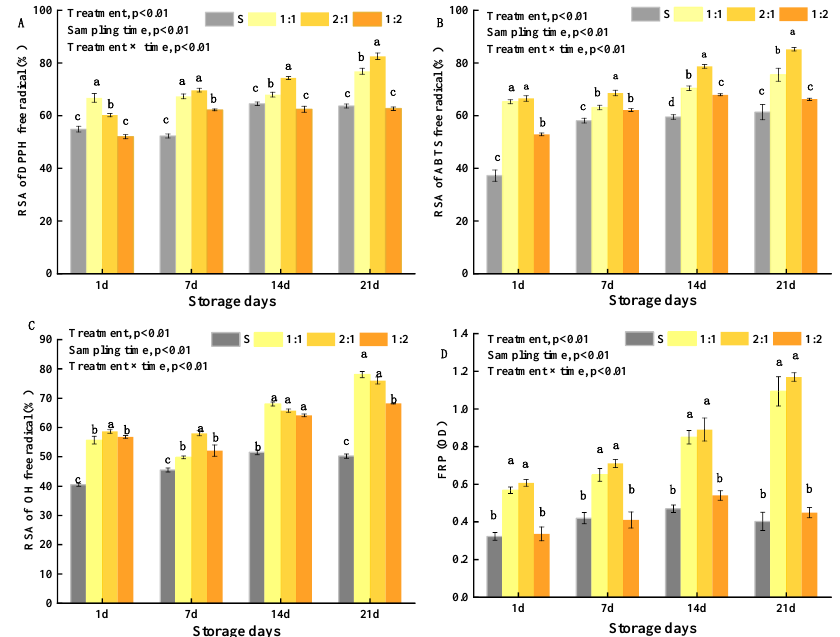
Figure 6. Antioxidative properties of EPS in yogurt were added with different proportions of MC5 during storage. ( A – C ) Radical scavenging activity (RSA) of DPPH, ABTS, and OH, respectively. ( D ) OD of ferric iron-reducing power (FRP). Error bars represent the standard errors (se) of the model-fitted mean value ( n = 3). “a, b, c, d” indicate significant differences within yogurt groups during storage at p < 0.05.